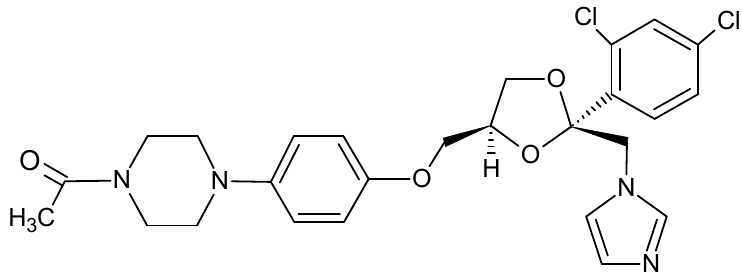
Figure 1. Chemical structure of the ketoconazole